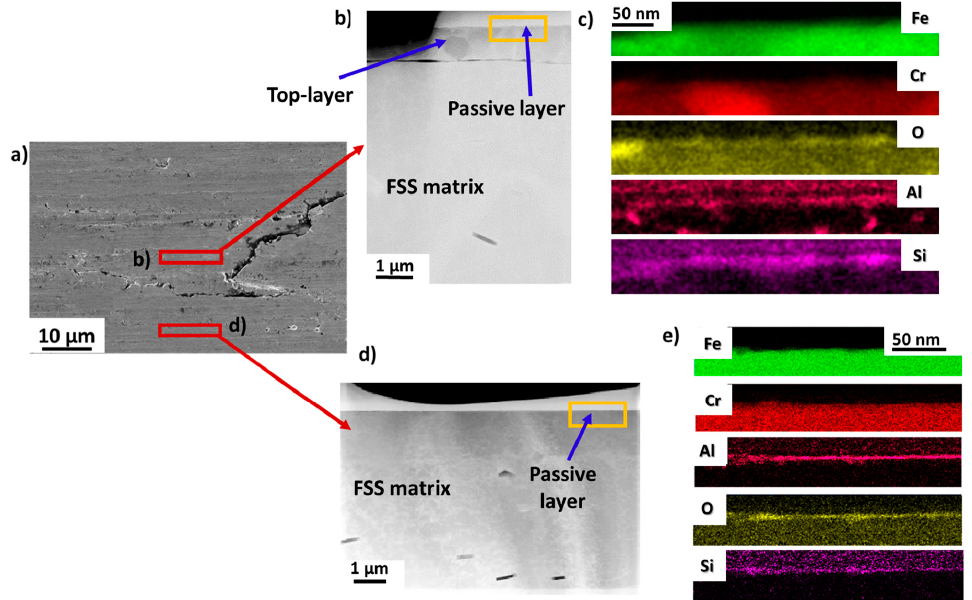
Figure 9. STEM analyses acquired on the FSS2 sample. ( a ) SEM micrograph. The two red rectangles highlight the areas which were used to prepare the TEM lamellas. ( b ) STEM-HAADF micrograph of an area affected by the GDD. The rectangle highlights the area used to perform the EDS analyses. ( c ) Corresponding EDS chemical maps. ( d ) STEM-HAADF micrograph of an area unaffected by the GDD. The rectangle highlights the area used to perform the EDS analyses. ( e ) Corresponding EDS chemical maps.